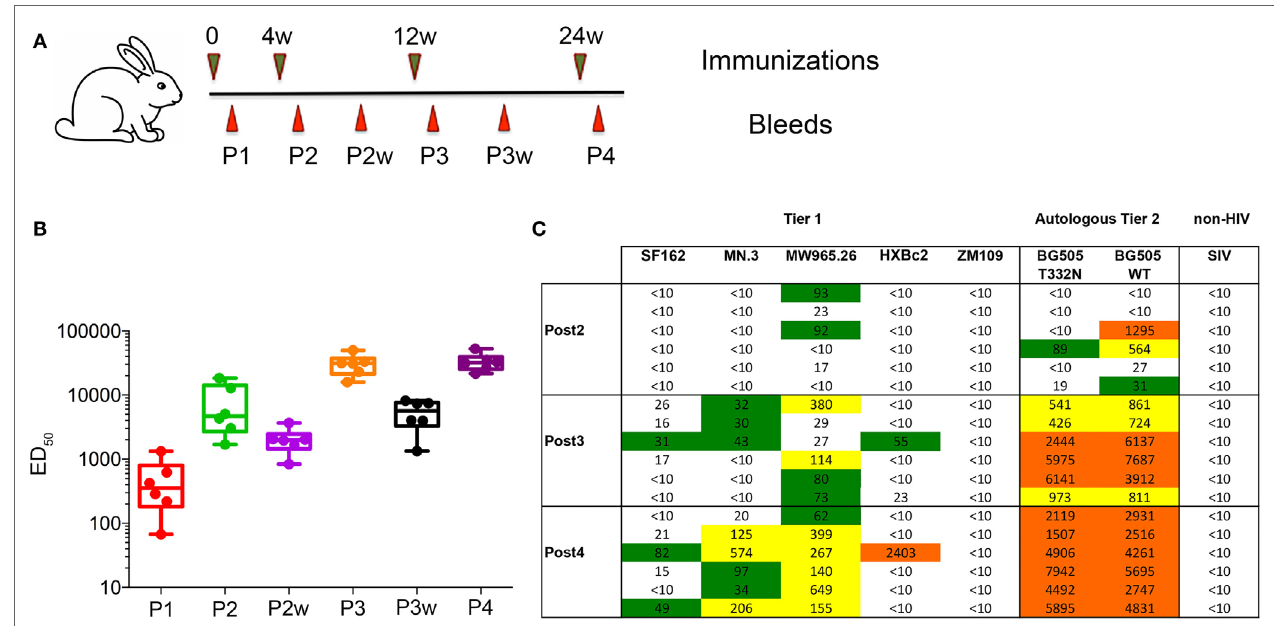
FigUre 4 | BG505 NFL trimers produced in CHO-M cell lines elicit robust tier 2 neutralizing antibodies. (a) Schedule of immunizations and bleeds. (B) Longitudinal analysis of BG505 NFL-specific antibodies elicited in rabbits. The geometric mean of binding titer (ED 50 ) for all the animals is plotted against various bleed